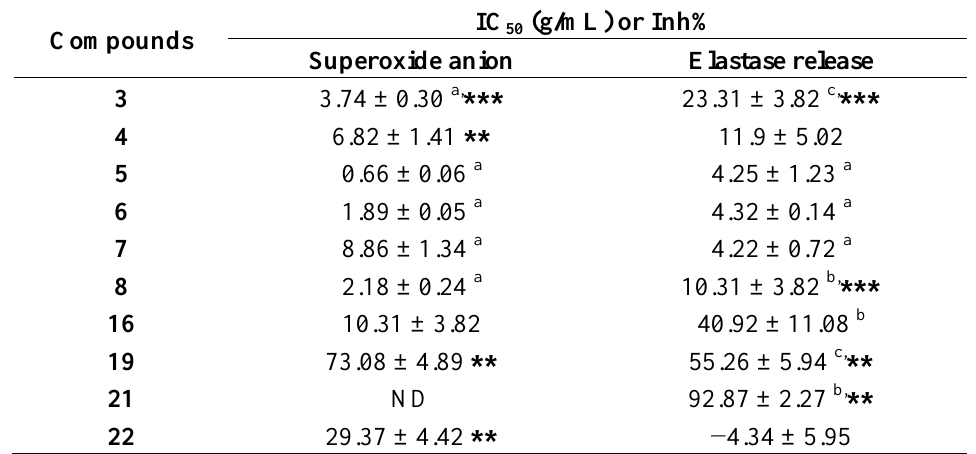
Table 4. Anti-inflammatory activity of pure compounds isolated from F. macrophylla . IC (g/mL) or Inh% 50 Compounds Superoxide anion Elastase